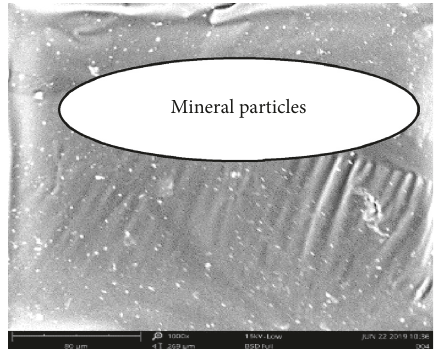
Figure 12: 20% of Buton-modified asphalt.